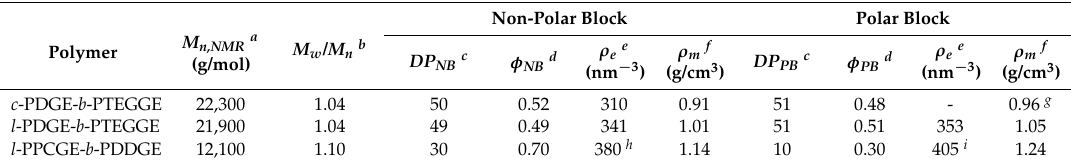
Figure 1. Chemical structures of the topological diblock copolymers in this study. Table 1. Molecular characteristics, degree of polymerization, and volume fractions of the topological polymers used in this study.